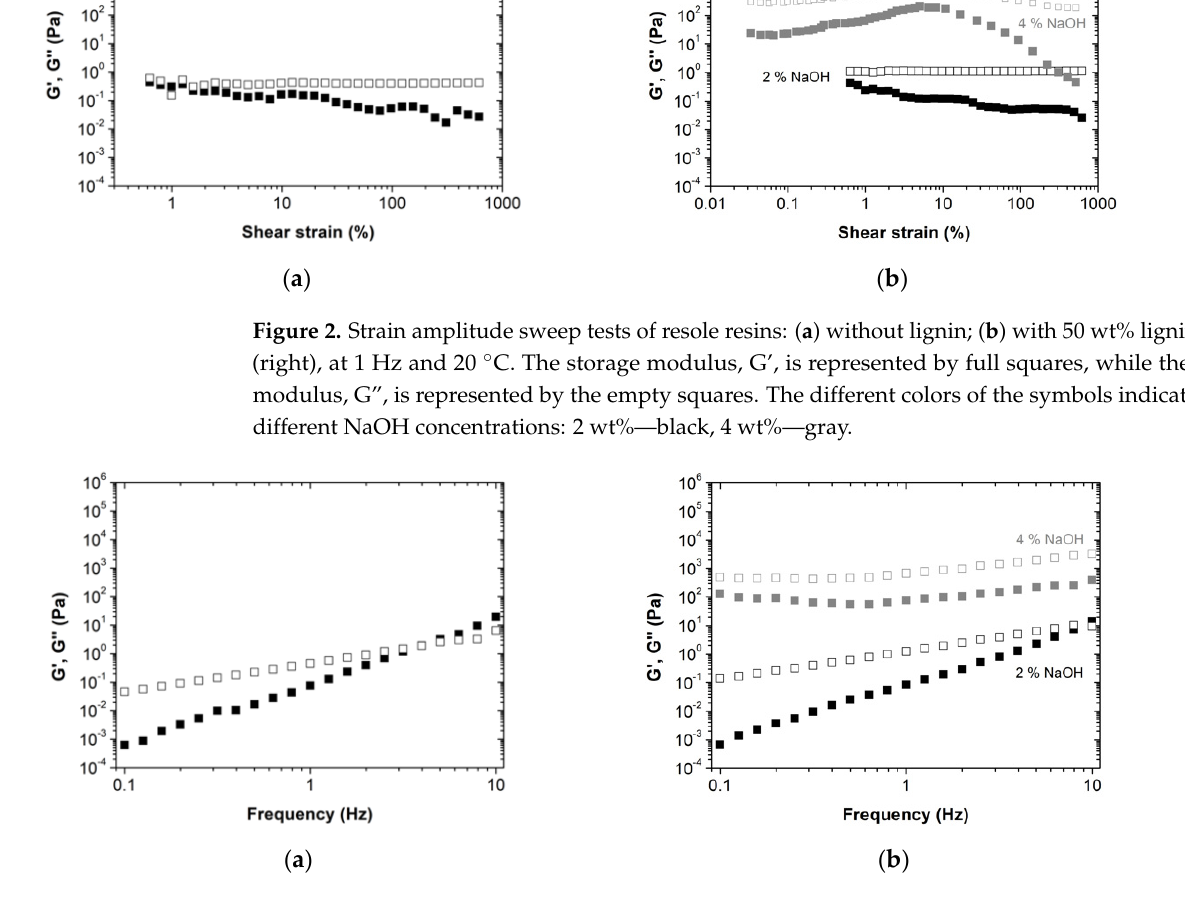
Figure 3. Frequency sweep tests of resole resins: ( a ) without lignin; ( b ) with 50 wt% lignin-LA (right), at 5 Pa and 20 °C. The storage modulus, G’, is represented by full squares, while the loss modulus, G’’, is represented by the empty squares. The different colors of the symbols indicate the different NaOH concentrations: 2 wt%—black, 4 wt%—gray.